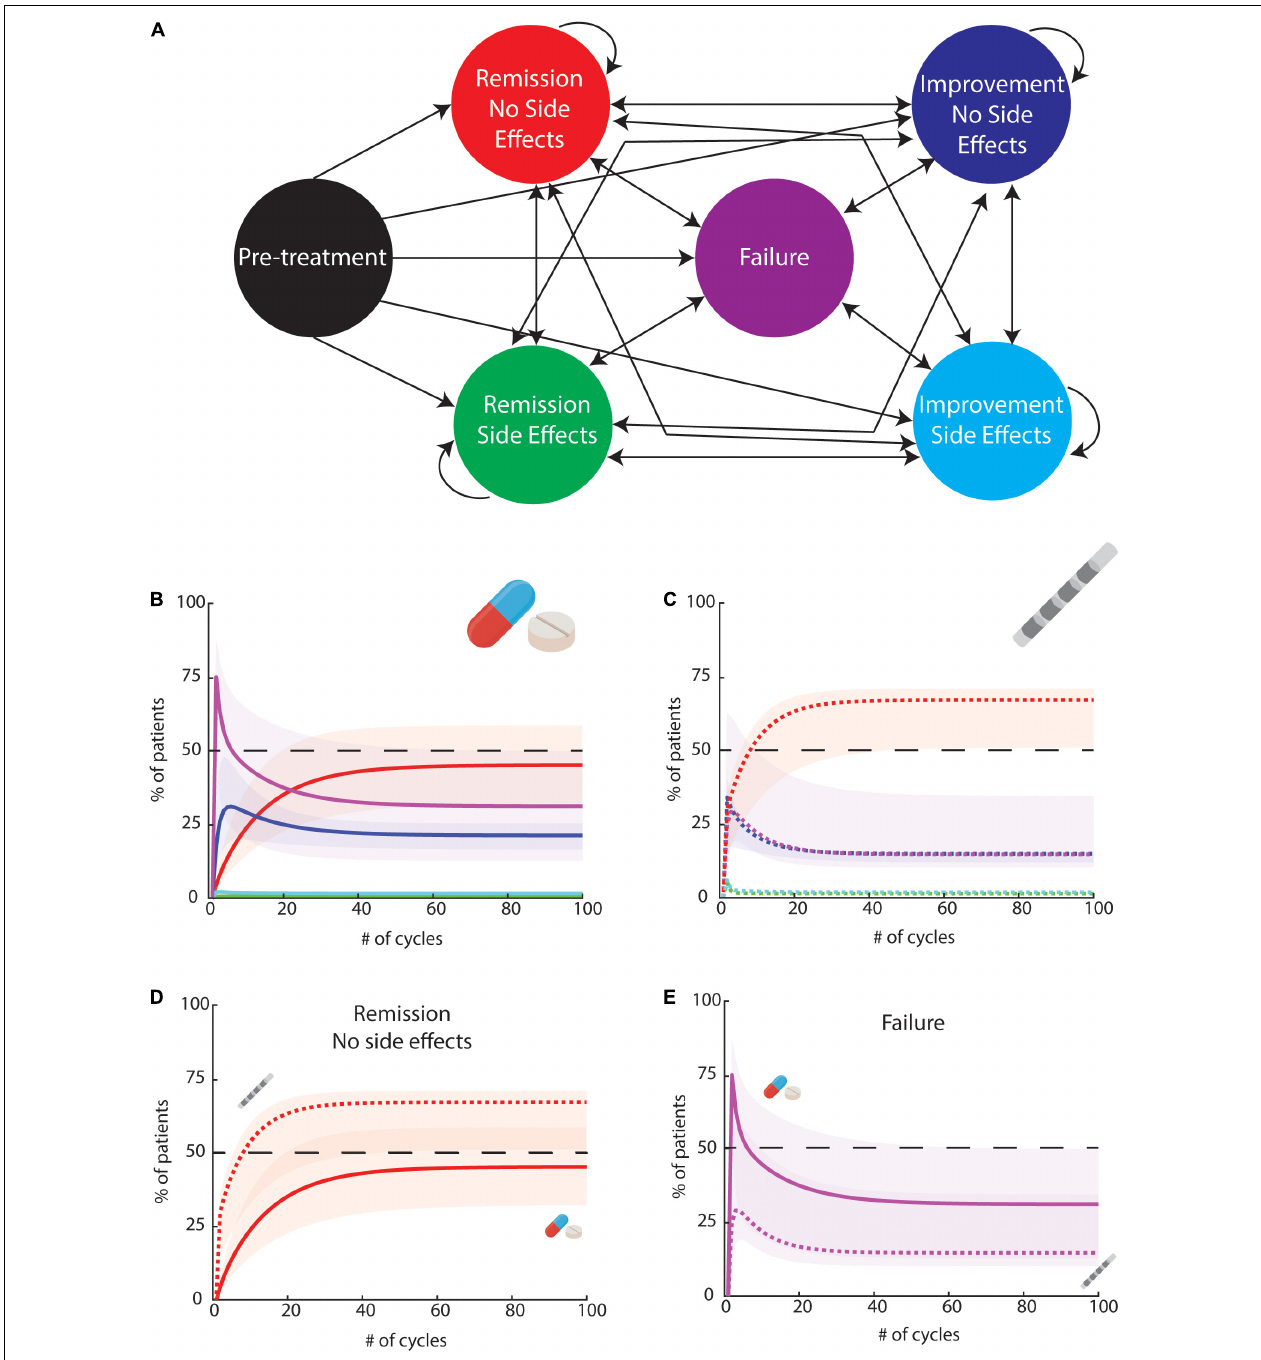
FIGURE 1 | A six-state Markov Model to study the effects of multiple medical treatment trials or DBS trials followed by therapeutic optimization. (A) State definitions: each circle represent a state. Arrows represent possible transitions. Transition probabilities are described in Supplementary Tables 1, 2 . The first state is never visited after the first cycle, so it was excluded from the panels bellow. (B) Result of the simulation of 100 cycles for medical therapy. The full lines represent the main model using the transition probabilities described in Supplementary Table 1 . Shaded color includes the interval of the results between 2 additional models using the same assumptions as the main model but with effectiveness reduced by a factor or 2, or increased by a factor of 2 (C) Result of the simulation of 100 cycles for DBS. The dashed lines represent the main model using the transition probabilities described in Supplementary Table 2 . Shaded color includes the interval of the results between 2 additional models using the same assumptions as the main model but with effectiveness reduced by a factor or 2 or increase by 20% (further increases were considered unrealistic based on available data). (D) Result for remission without side effects for medical therapy (full line) and DBS (dashed line). We found that 66.5% of DBS responses were superior to the range of medical responses. (E) Result for failure without side effects for medical therapy (full line) and DBS (dashed line). 40.5% of possible medical responses were found to be worse than DBS responses.